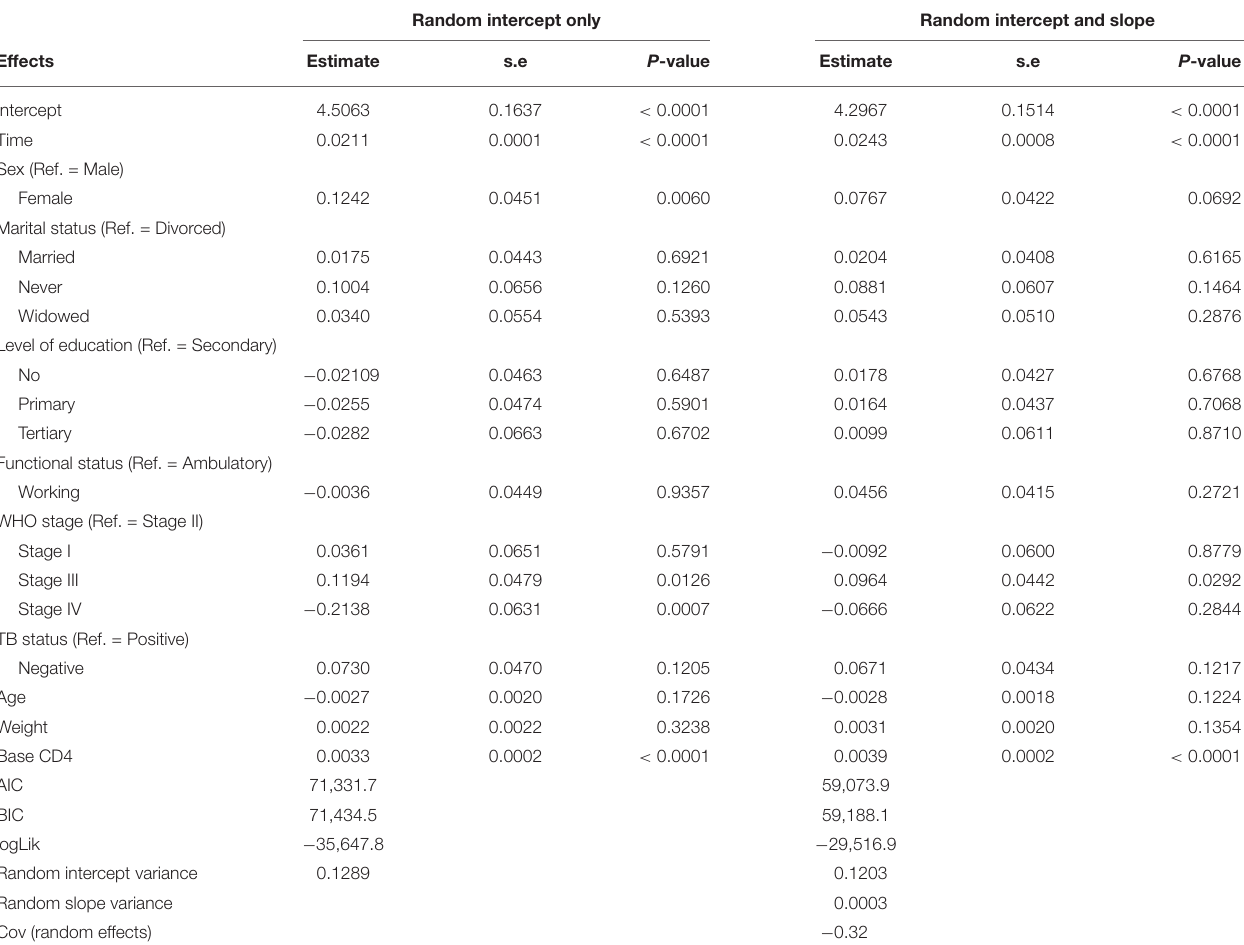
TABLE 5 | Poisson-Normal